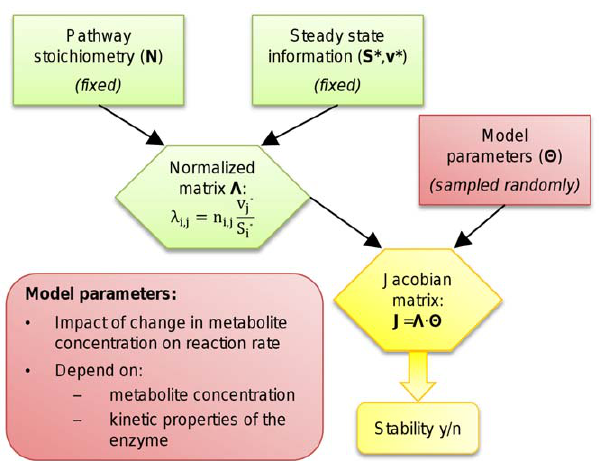
Figure 2. The principles of structural kinetic modeling. Normalization of the pathway-specific stoichiometric matrix N with respect to steady state concentrations S (cid:2) and fluxes v (cid:2) produces the normalized matrix L . Together with the model parameters in the matrix H , it uniquely defines the Jacobian matrix of the system in the steady state. Evaluation of the eigenvalues of the Jacobian matrix then indicates whether the steady state is stable.